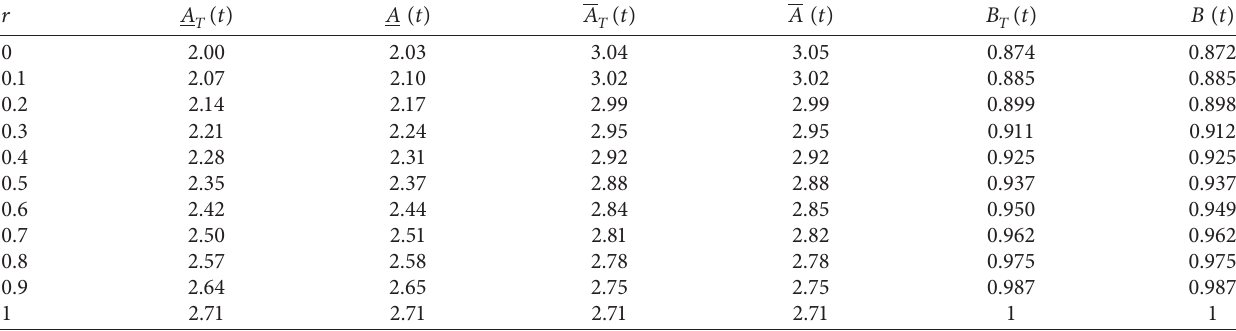
T approximated solutions for λ